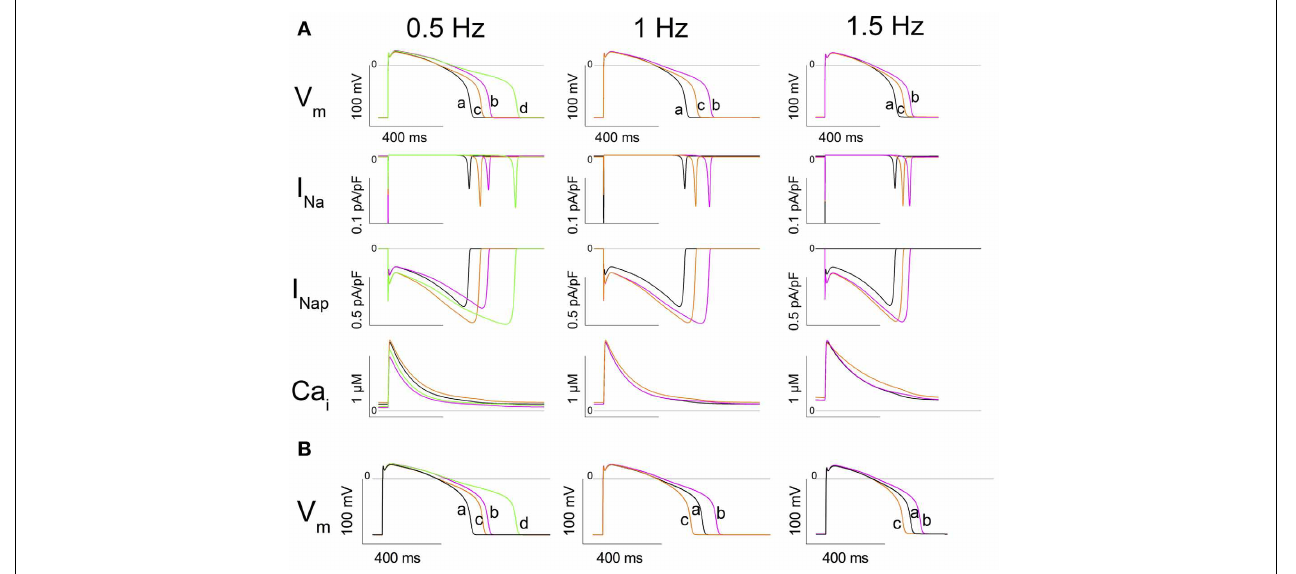
FIGURE 7 | In silico simulation of heterozygous cardiomyocytes carrying the Q1476R mutation. (A) The three columns correspond to different stimulation frequencies indicated at the top of the figure. From top to bottom: the action potential (AP), the fast sodium current (INa), the persistent sodium current (INap), and cytosolic [Ca 2 + ] (Ca i ). Under column 0.5Hz, traces at SS are superimposed: trace a: WT at 1Hz (black), trace b: WT at 0.5Hz (magenta), trace c: WR (1/2 WT + 1/2 Q1476R) at 1Hz (orange), and trace d: WR at 0.5Hz (green). Under column 1Hz, trace a is WT at SS at 1Hz, trace b